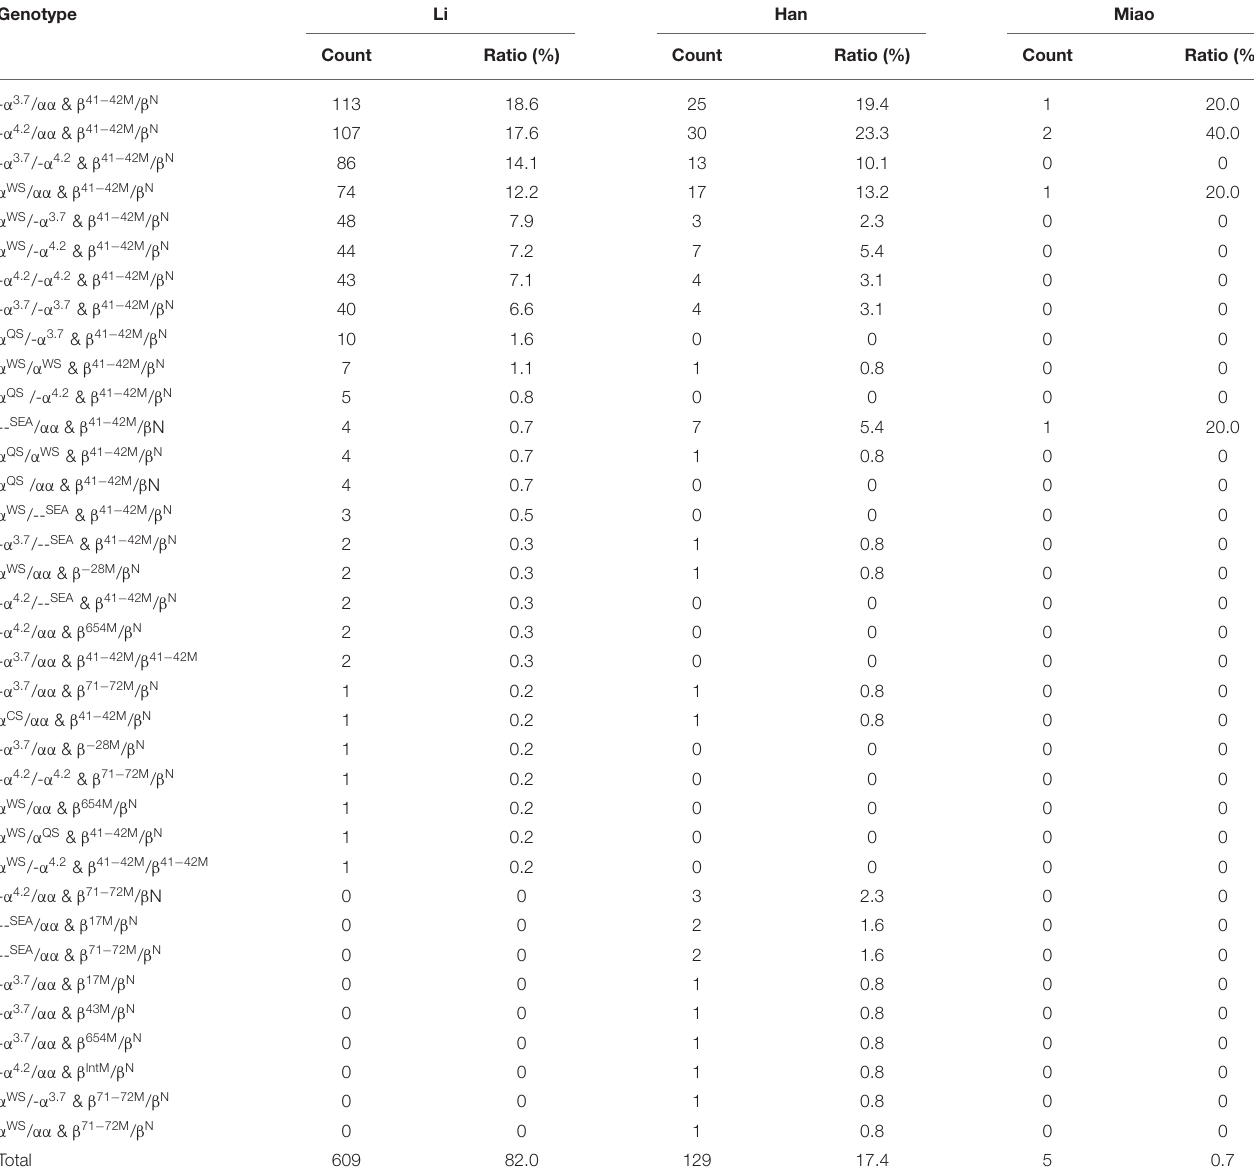
TABLE 8 | Distribution of α -composite β -thalassemia genotypes in the Han people and ethnic minorities in the southern area of Hainan. Genotype Li Han Miao Count Ratio (%) Count Ratio (%)